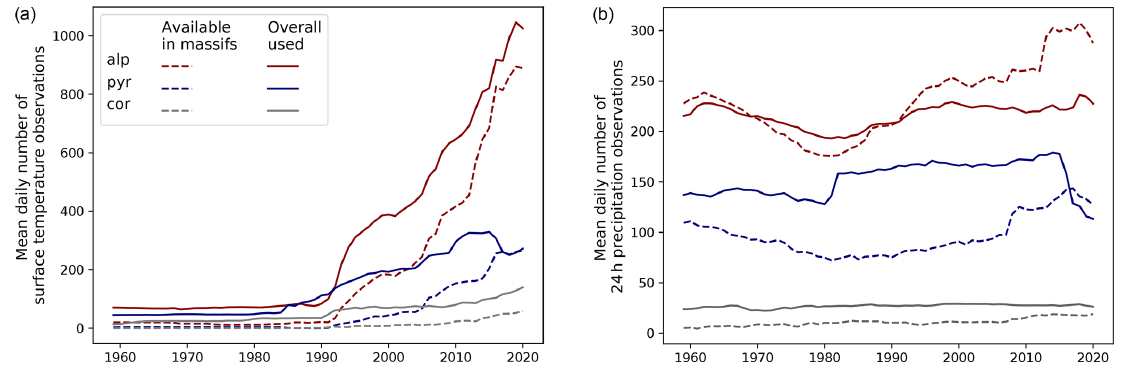
Figure 4. Temporal evolution of the daily mean number of surface temperature (at 2m, a ) and 24h precipitation (b) observations available within the massifs limits (dashes) and effectively assimilated (solid lines) for each mountainous area over the period covered by the